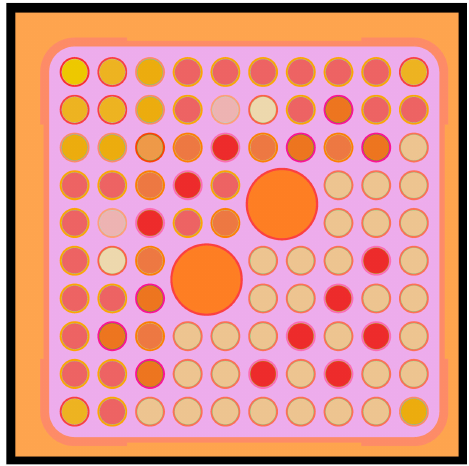
Figure 3. Layout of Application ATF Assembly.